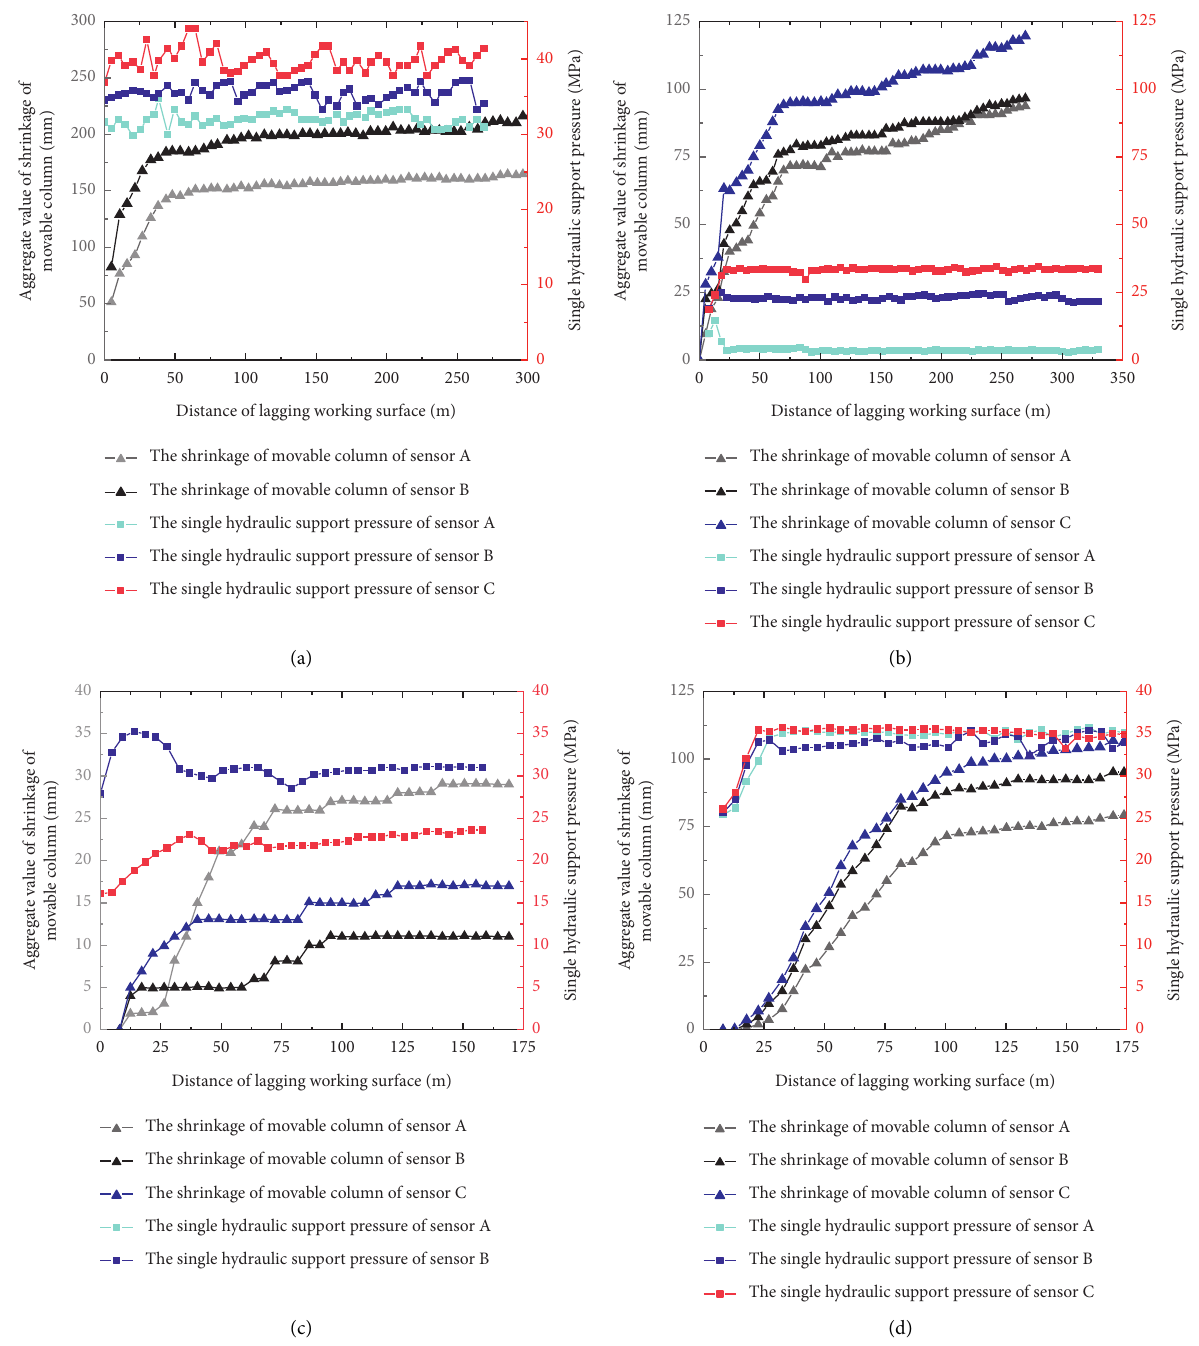
Figure 9: Data recorded at each monitoring point in the section along the hollow lane: (a) No. 2, (b) No. 7, (c) No. 12, and (d) No.